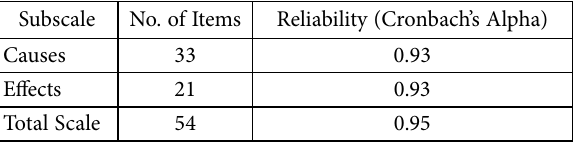
Table 3. Reliability of the survey instrument